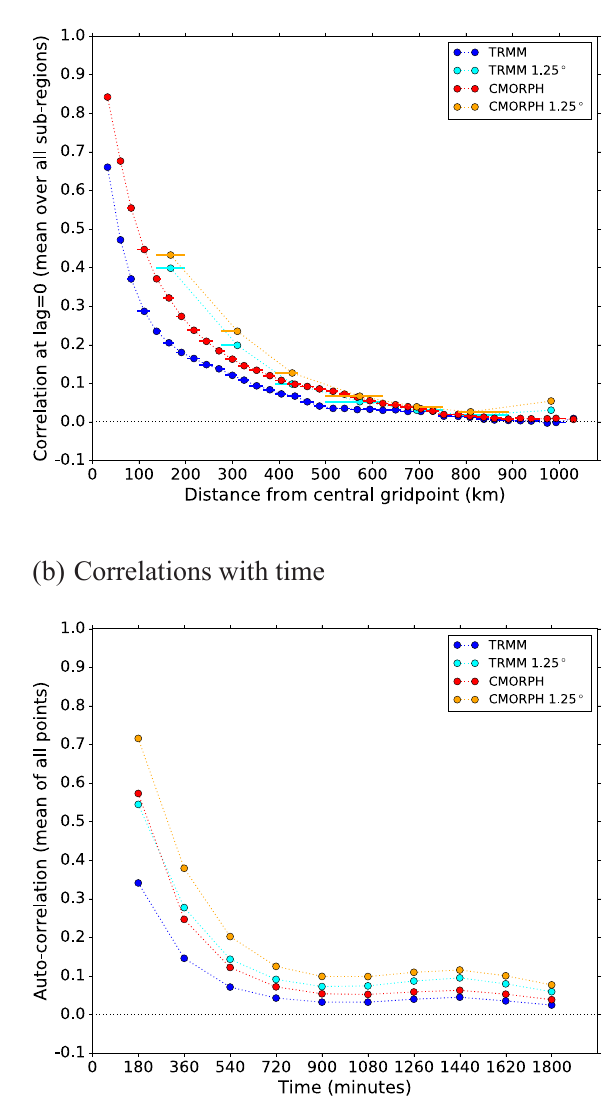
Figure 3. For TRMM 3B42 and CMORPH 0.25 ◦ and 1.25 ◦ data: (a) a measure of the spatial scale of precipitation features, com- puted by dividing the analysis domain into 1500km × 1500km re- gions and calculating the lag-0 correlation between the central grid- point and gridpoints within each distance bin (which are (cid:49)x wide, starting from 0.5 (cid:49)x ) away from the central gridpoint, then averag- ing the correlations over all regions in the domain; (b) a measure of the temporal scale of precipitation features, computed as the auto- correlation of precipitation, averaged over all points in the domain. The horizontal lines in (a) show the range of distances spanned by each distance bin; the filled circle is placed at the median distance. For clarity, we omit the correlations for zero distance and zero lag, which are 1.0 by